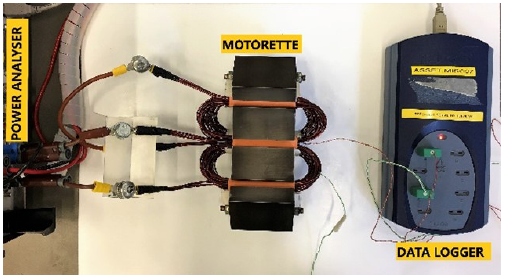
Figure 5. Schematic diagram of the experimental setup showing the AC source, the power analyser and the motorette inserted.